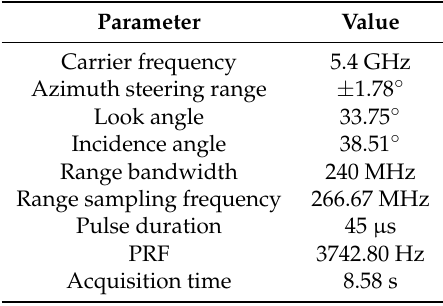
Table 6. Main Parameters of GF-3 Raw Data in Spotlight Mode.